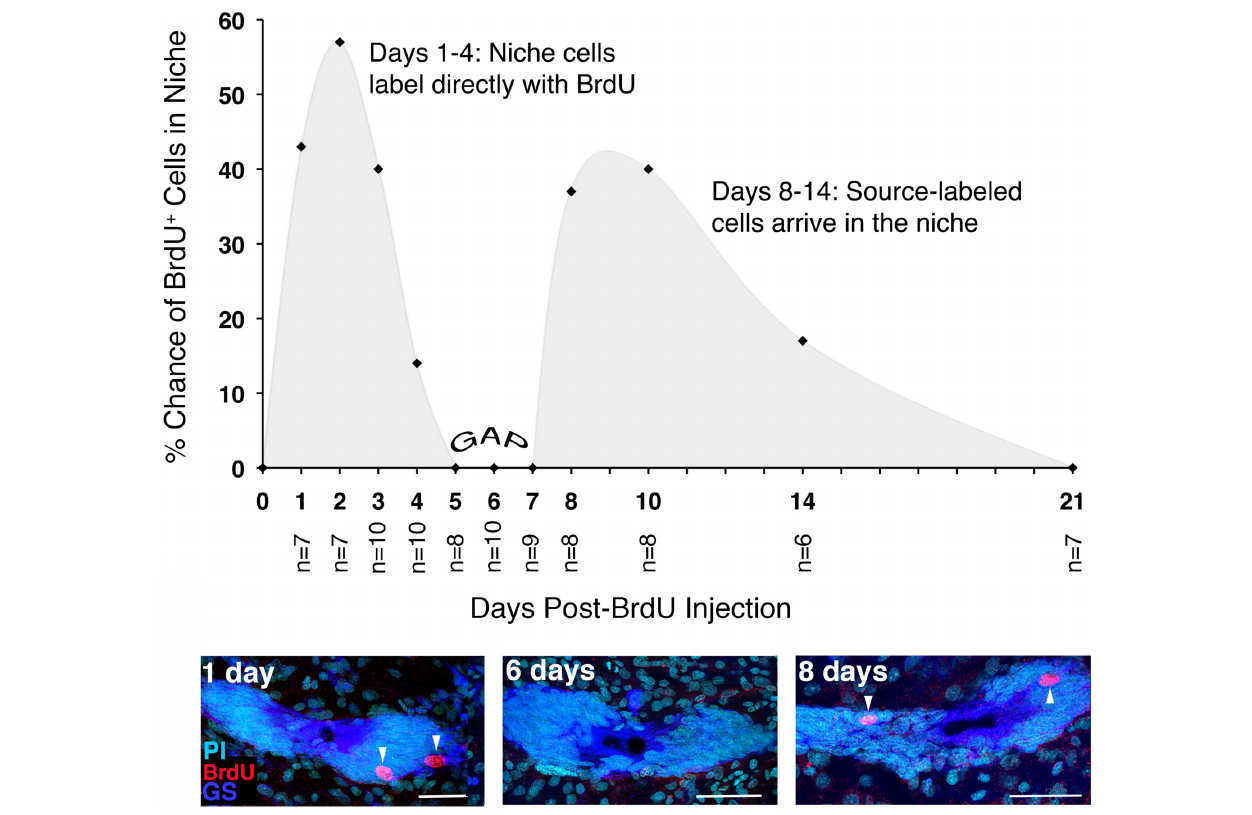
FIGURE 4 | Actively proliferating (BrdU + ) cells in the neurogenic niche have a bimodal temporal distribution. BrdU + cells were quantified in the niches of crayfish that were sacrificed daily for 1 week after BrdU injection, and at intervals thereafter for 21 days. The probability of observing BrdU + cells in the niche was then plotted for each of the sampling days. BrdU + cells were observed in the niche on days 1–4 following injection (shown in the day 1 image below graph). On days 5–7, the niches contained no BrdU + cells (GAP). However, between days 8 and 14 after injection, BrdU + cells were once again observed in the niche. Adapted from Benton et al. (2014) . Scale bar: 50 µ